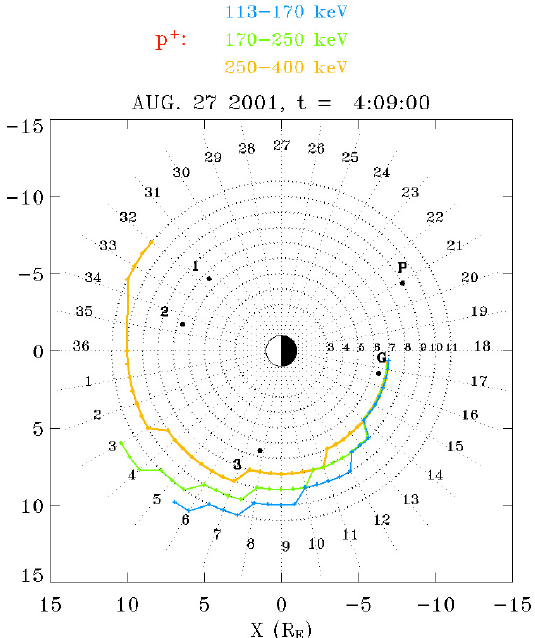
Fig. 3. Locations of initial proton flux increase in the 250–400keV energy channel (yellow line), 170–250keV (green line) and 113– 170keV energy channel (dark-blue line) and of the proton disper- sionless injection boundary.